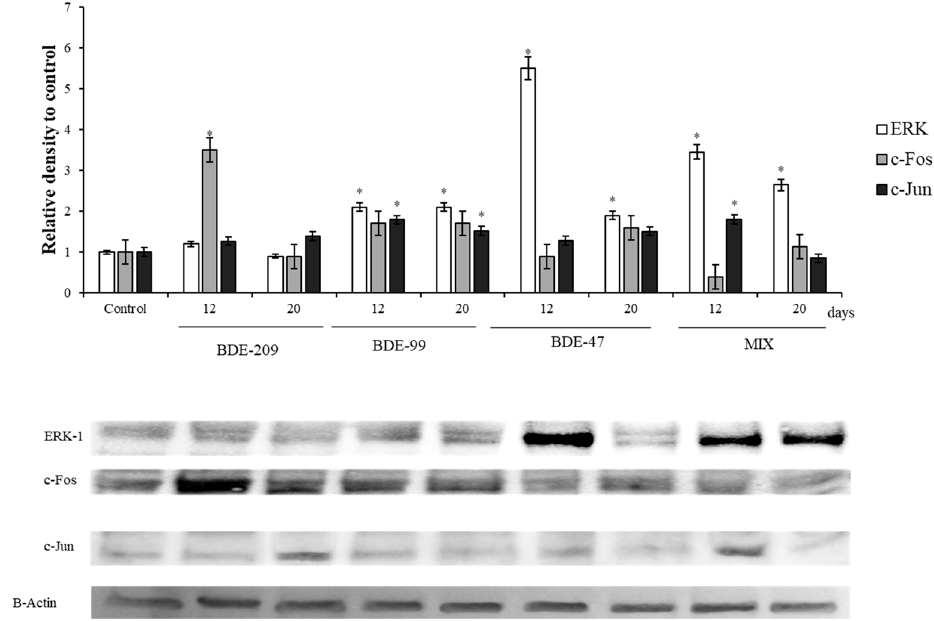
Figure 4. Immunoblotting of ERK, c-Jun and c-Fos, evaluated on HS-68 cells exposed to 1 µmol/L BDE 209, 99, 47 and MIX for 12 and 20 days. Actin was used as internal control. The images are representative of at least three separate experiments. The relative protein quantification is represented in the graphic (* p < 0.05).